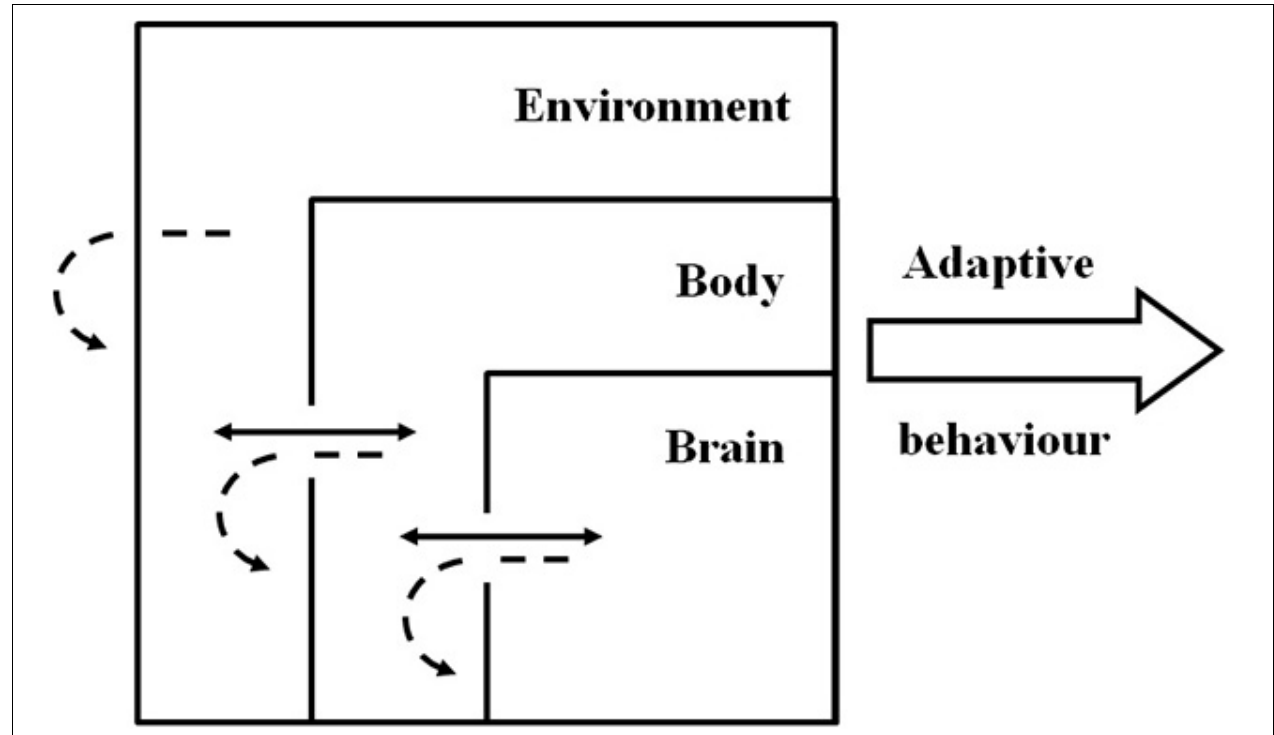
FIGURE 2 | Schematic representation of the situated-dynamic-embodied framework with adaptive behavior resulting from the emergent characteristics of brain-body-environment coupling and not from